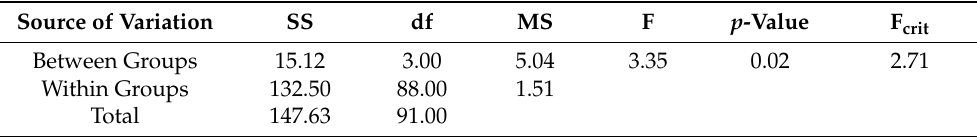
Table 8. ANOVA for CW for the 1.5 mm thick samples welded with and without nitrogen in the shielding gas.